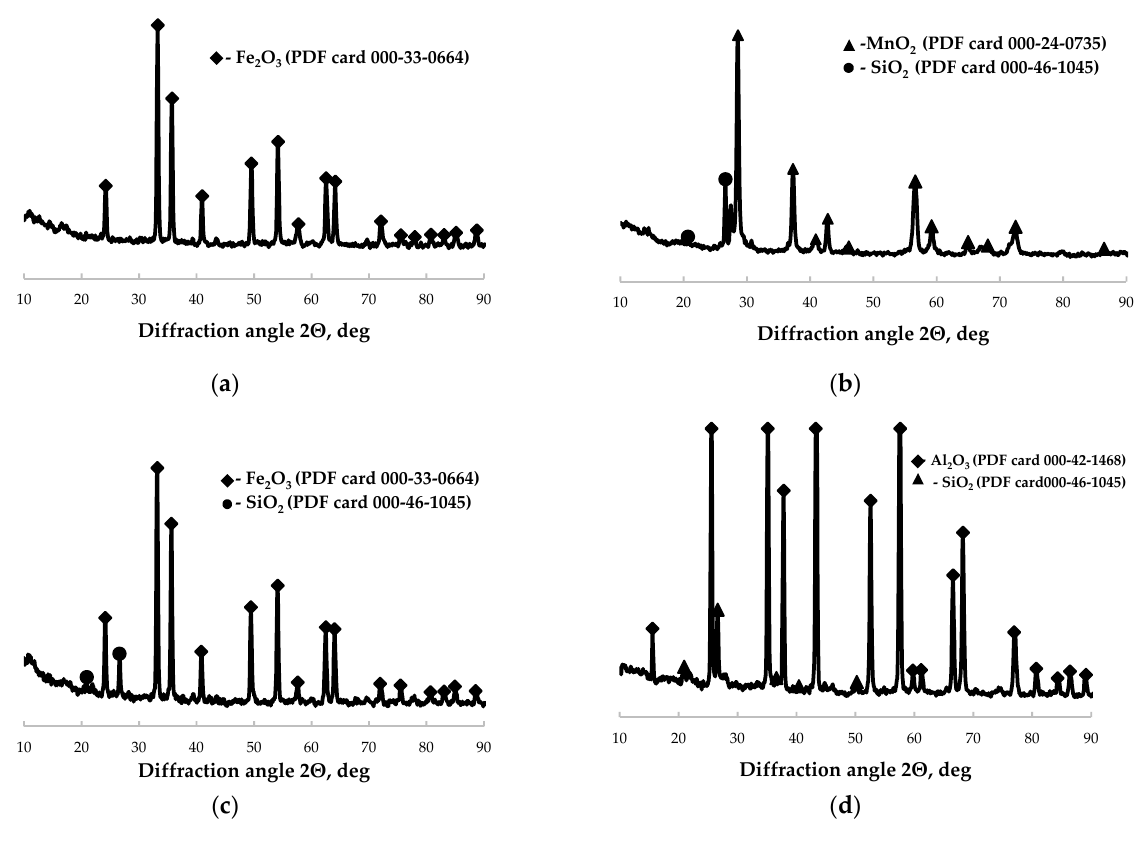
Figure 3. X-ray diffraction pattern of fine and coarse aggregates of concrete compositions: ( a ) = iron oxide powder; ( b ) = manganese oxide powder; ( c ) = iron ore pellets; ( d ) = alundum. Component composition of the concrete compositions is given in Table 1. Table 1. Composition of concrete.